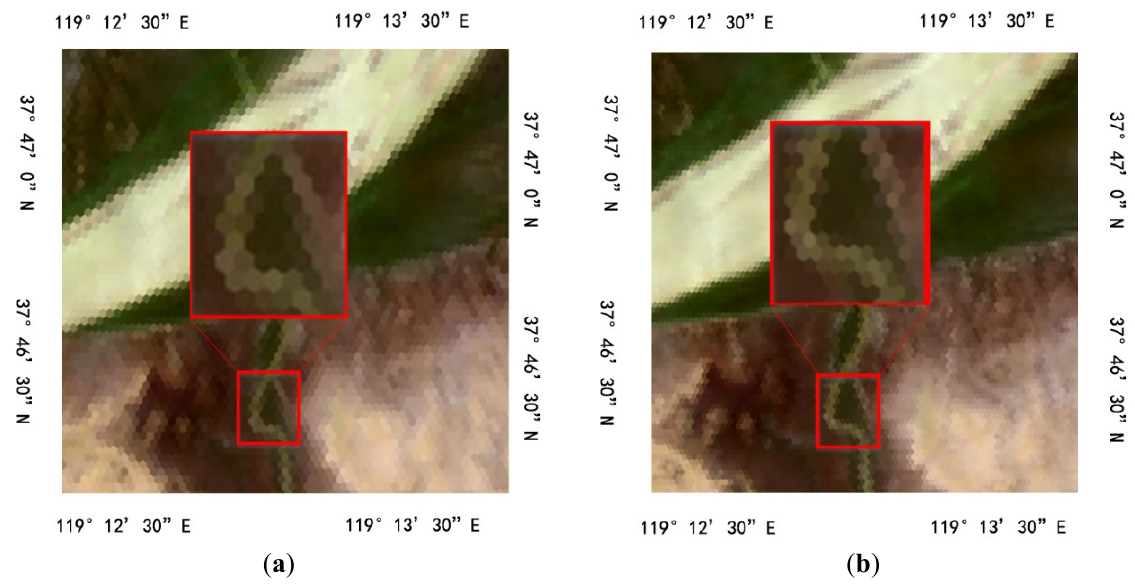
Figure 12. Expression of a Landsat 8 image based on hexagonal grids on different levels: ( a ) Level 18; ( b ) Level 19.